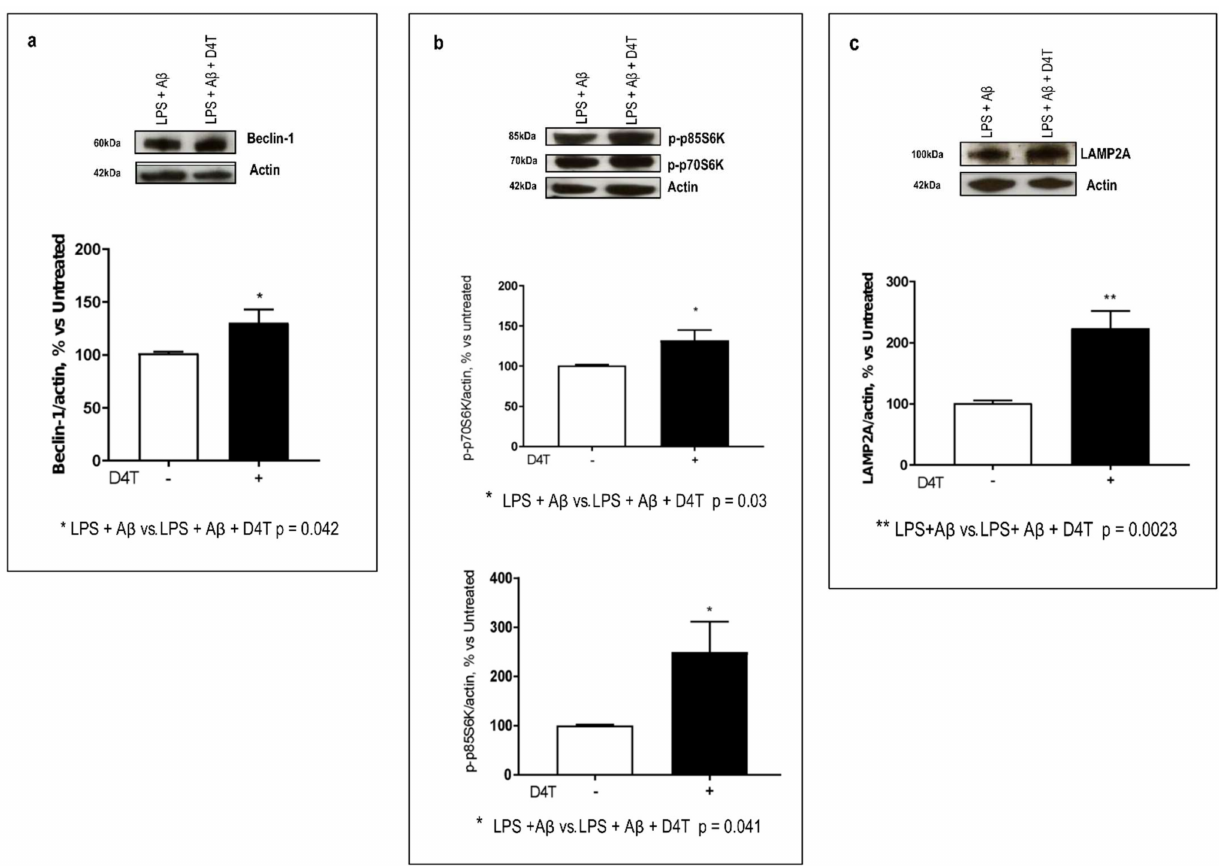
Figure 4. Beclin-1- and CMA-mediated autophagy proteins. Western blot analyses of Beclin-1 (( a ), 52 KDa) and its downstream targets phospho-p70S6K and phospho-p85S6K (( b ) 70 and 85 KDa) and Lamp2A (( c ) 100 KDa), the receptor for CMA, are shown. Each result is expressed as a percentage of the ratio between the protein expression or phosphorylated-kinase and actin expression versus D4T-untreated cells. Statistical significance is shown as (** p < 0.001, * p < 0.05). Representative blots from independent experiments are shown in the upper part of panels ( a – c